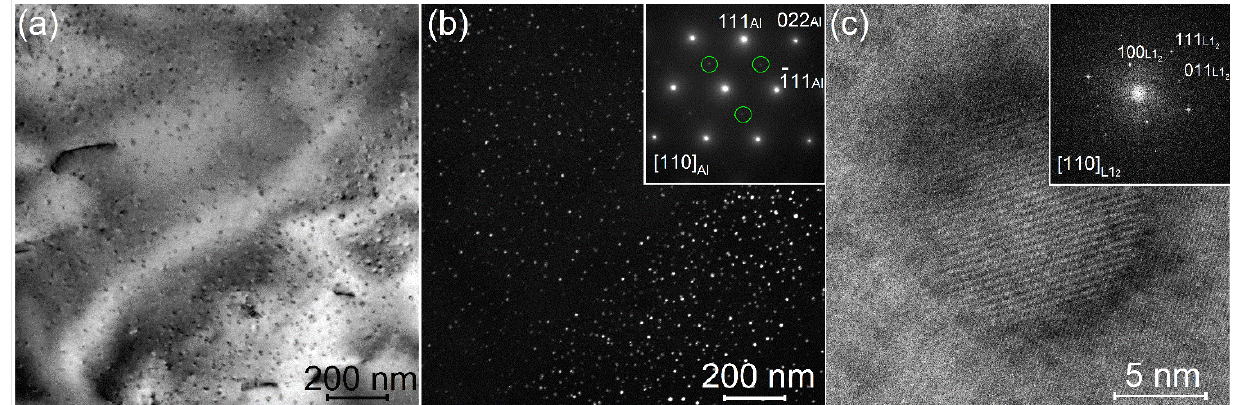
Figure 5. TEM micrographs for the 4C alloy; ( a ) bright field; ( b ) dark field; ( c ) high-resolution image of dispersoid; insert in ( b ) is corresponding SAED and insert in ( c ) is corresponding FFT.